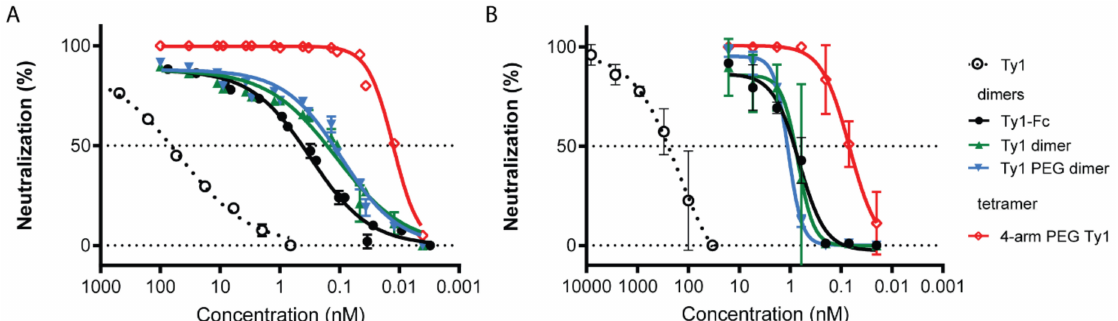
Figure 3. Ty1 multimeric constructs neutralize SARS-CoV-2 spike pseudotyped lentivirus and infectious SARS-CoV-2. ( A ) SARS-CoV-2 spike pseudotyped lentivirus was incubated with a dilution series of Ty1, Ty1-dimers, and 4-arm PEG Ty1, and the percent reduction in infectivity relative to control wells